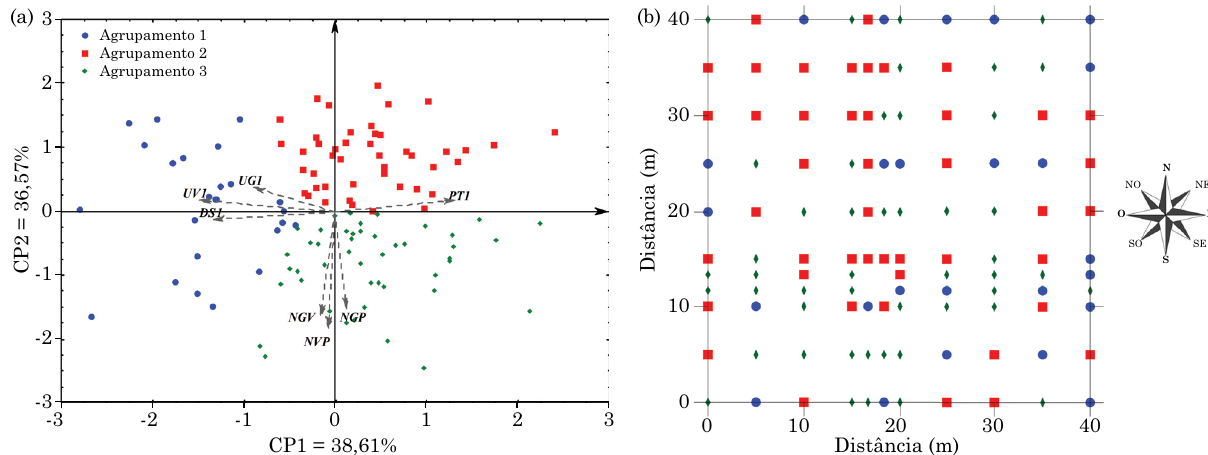
Figura 1. Dispersão ( gráfico biplot ) (a) e distribuição espacial dos grupos gerados (b) dos componentes da produção do feijão e de alguns atributos físicos de um Latossolo Vermelho distroférrico para a profundidade de 0,00-0,10 m, cultivado com milho/feijão em cultivo